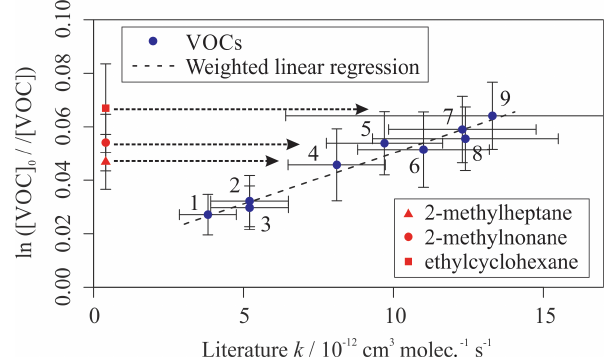
Figure 4. Relative rate plot for Mixture 4 (OH reactivity of 43s − 1 ) and 50ppb NO, at 296K. Compounds with a reference rate coeffi- cient for reaction with OH were plotted using their evaluated liter- ature values. Errors on the y axis, equal to 1 standard error, were calculated by combining the standard error in peak areas for six lamp-off and six lamp-on samples. Error bars on the x axis were typically large and accounted for deviations from the line for all VOCs. A weighted (to the uncertainty in the y values) linear fit was used to generate the slope, with a value of OH exp = 3 . 8 ( ± 0 . 2 ) × 10 9 molec.cm − 3 s and R 2 = 0 . 971. Data for 2-methylheptane, 2- methylnonane, and ethylcyclohexane, which had no literature k (298K) values, were not used in the calculation of the fit but were included on the plot to illustrate their measured depletion factors. The dashed arrows indicate that the k values for the target com- pounds are determined by where they would fall on the measured OH exp curve. The VOCs can be identified as follows: (1) 2,2,3- trimethylbutane; (2) 2-methylpentane; (3) 3-methylpentane; (4) n - octane; (5) n -nonane; (6) n -decane; (7) n -undecane; (8) cyclohep- tane; (9)